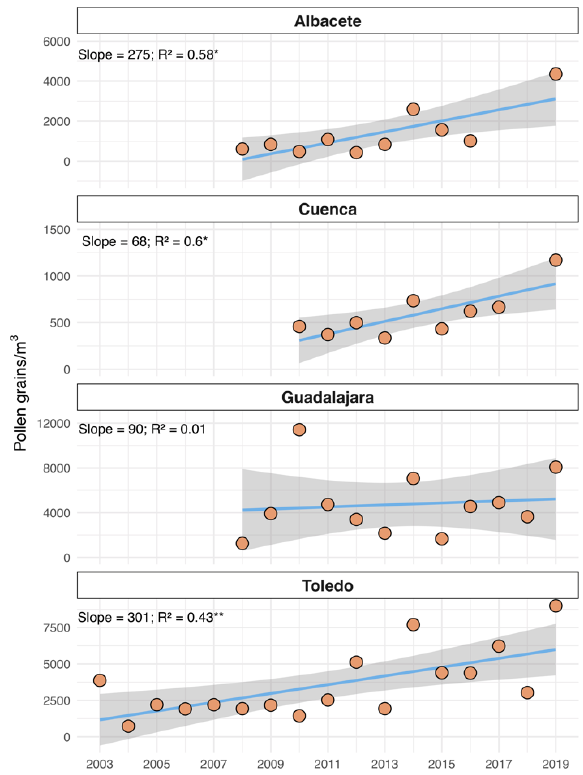
Figure 2. Trends of the annual pollen integral of Platanus pollen. Levels of significance: * p < 0.05, ** p < 0.01. Blue line represents the regression line and grey zone corresponds to 95% confidence interval.